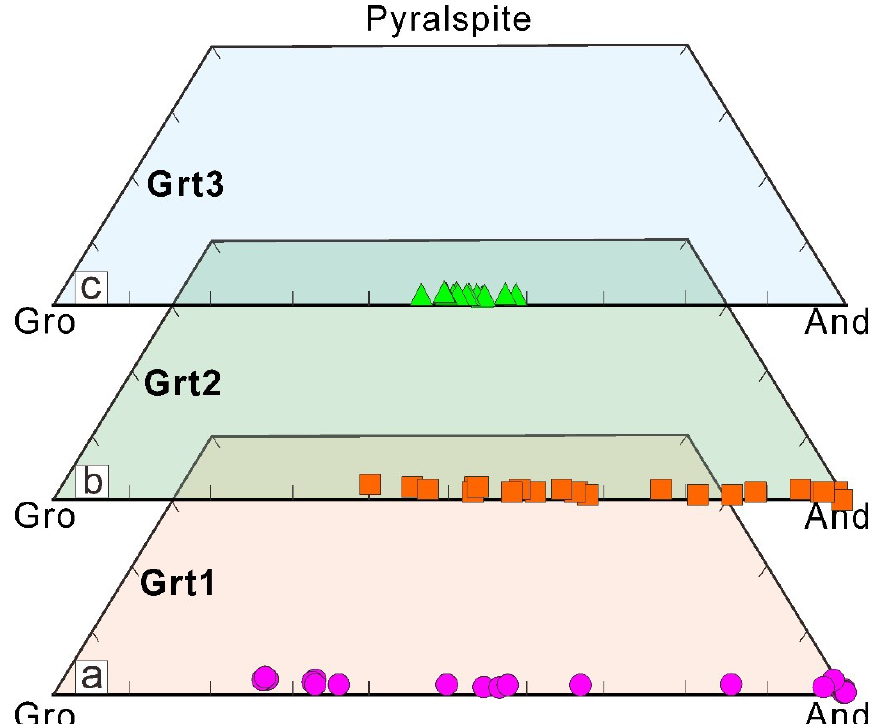
Figure 9. Triangular classification of garnets in the Yamansu deposit (the base diagram is modified after [32]). ( a ) Grt1—Garnets of the first generation with dramatic changes of end-member compositions (andradite and grossular); ( b ) Grt2—Garnets of the second generation with relative enrichment of andradite contents; ( c ) Grt3—Garnets of the third generation with little variation in end-member compositions. And = andradite; Gro = grossular; Pyralspite = spessartine + pyrope + almandine + uvarovite.